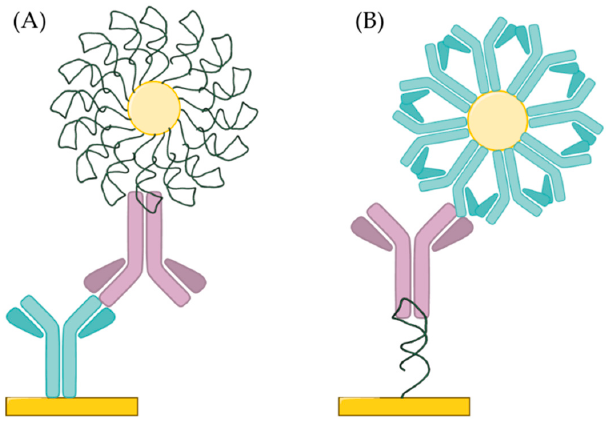
Figure 7. Methods for signal enhancement with aptamer ( A ) or anti-IgE ( B ) modified gold nanoparticles in SPR for IgE detection